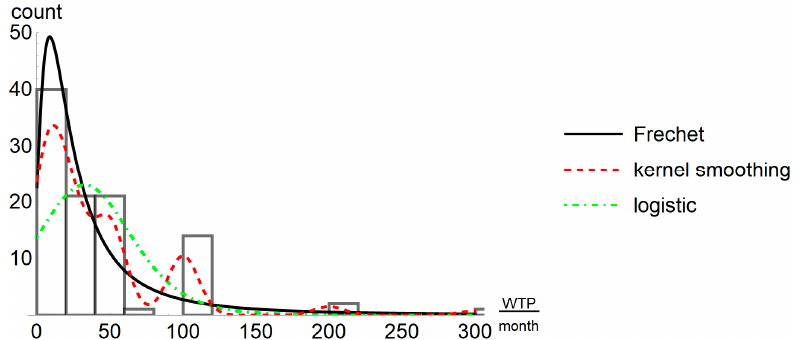
Figure 6. Histogram of the willingness to pay (WTP)/month (in INR) of HHs from the Raisen 2015 survey (100 data) and probability density functions: Frechet distribution (black) with maximum-likelihood parameters a = 1.69, b = 29.27, m = − 13.46, logistic distribution (dot-dashed green) with maximum-likelihood parameters m = 32.51, s = 21.78), and smooth-kernel distribution of the data (dashed red). To obtain comparable scales these were multiplied with 2000 (100 data times 20 bin width); plot and computations with Mathematica 11.3.